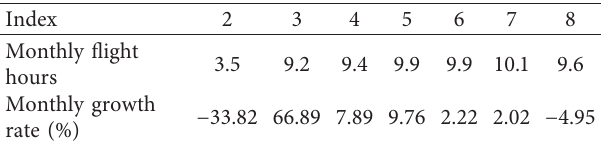
Table 1: Flight hours of general aviation production operation in 2019 (10,000